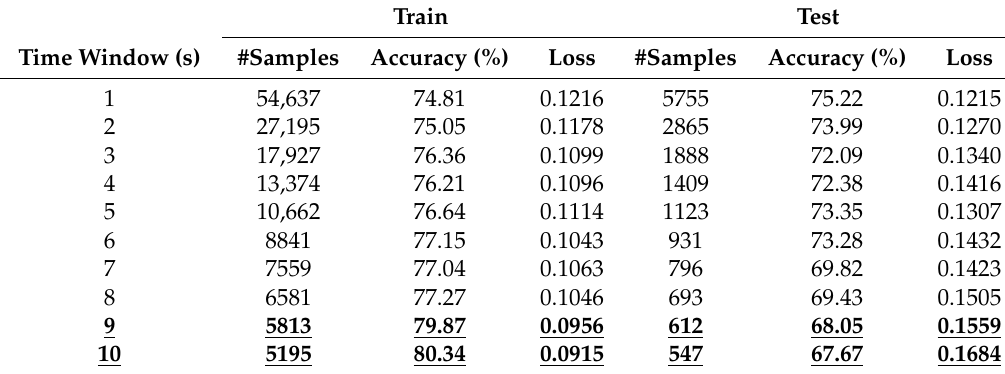
Table 7. Results obtained with EEG network classifying Valence (best time windows are marked). Train Test Time Window